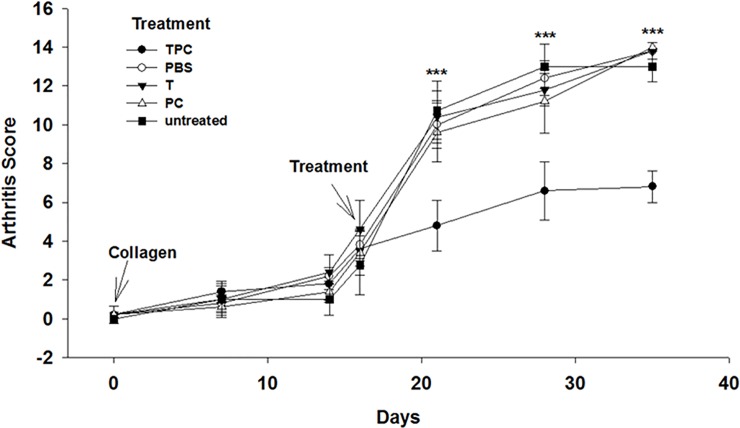
The effect of TPC on arthritis scores in DBA/1J CIA mice.The data are presented as arthritis score of s.c. treated CIA mice, measured from day (0) (disease induction) until day 35 mean ± SD. Tuftsin-phosphorylcholine (TPC) (n = 10), PBS (n = 10), tuftsin (T) (n = 10), phosphorylcholine (PC) (n = 10), untreated (n = 10). Values are mean ± SD. ***P < 0.001.